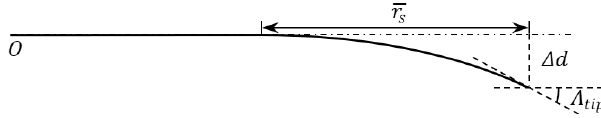
Figure 5. The parameterization of the swept blade with sweep ratio ¯ r s , sweep magnitude (cid:49)d and tip sweep angle (cid:51)